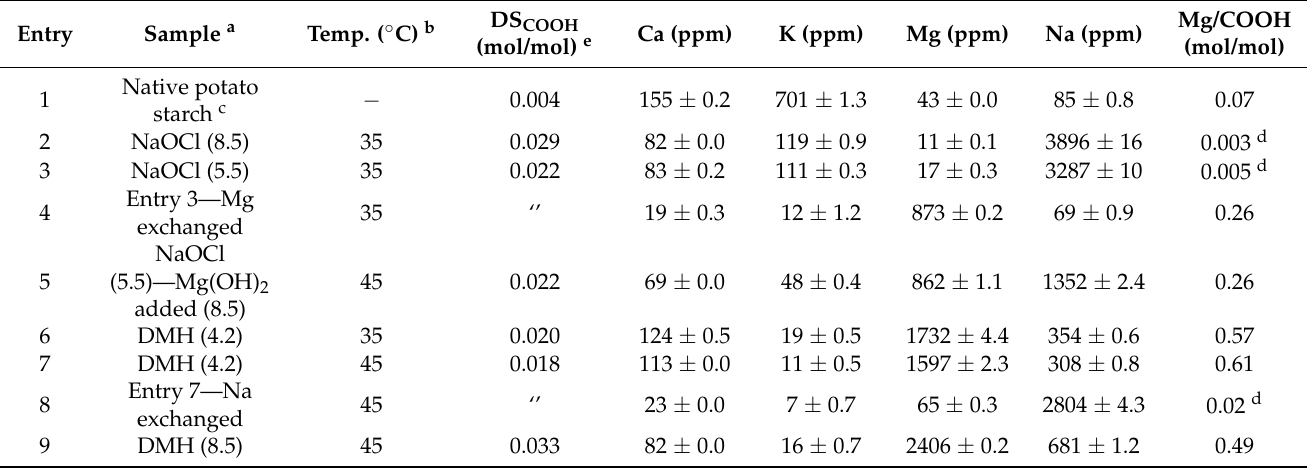
Table 1. Degree of oxidation (DS COOH ) and mineral content of NPS and starches oxidized with NaOCl and